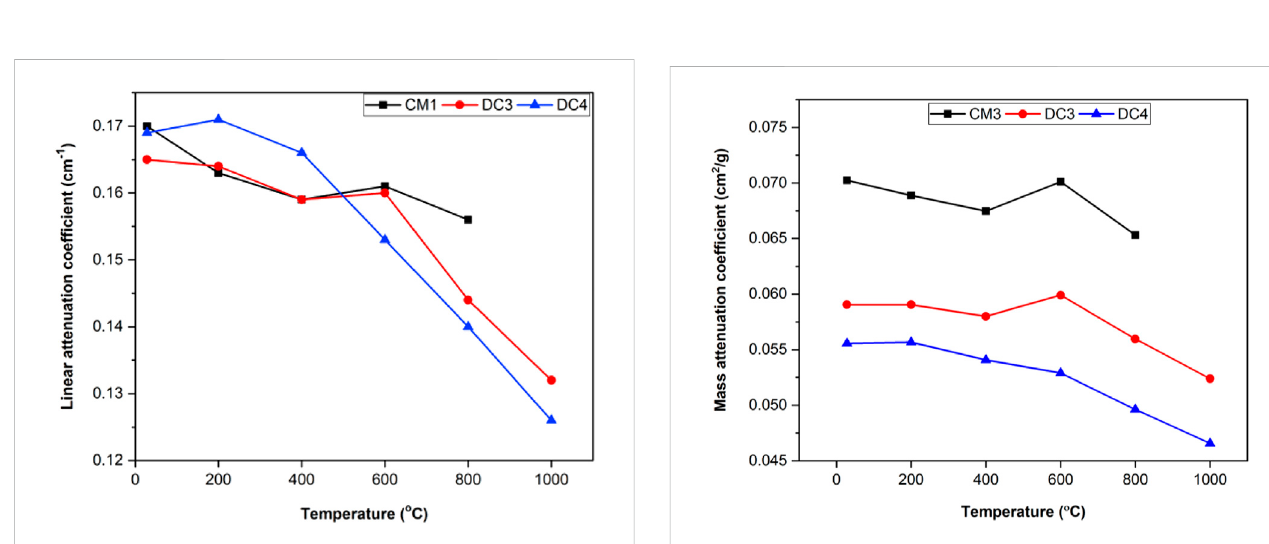
FIGURE 17 Mass Attenuation Coef fi cient as function of